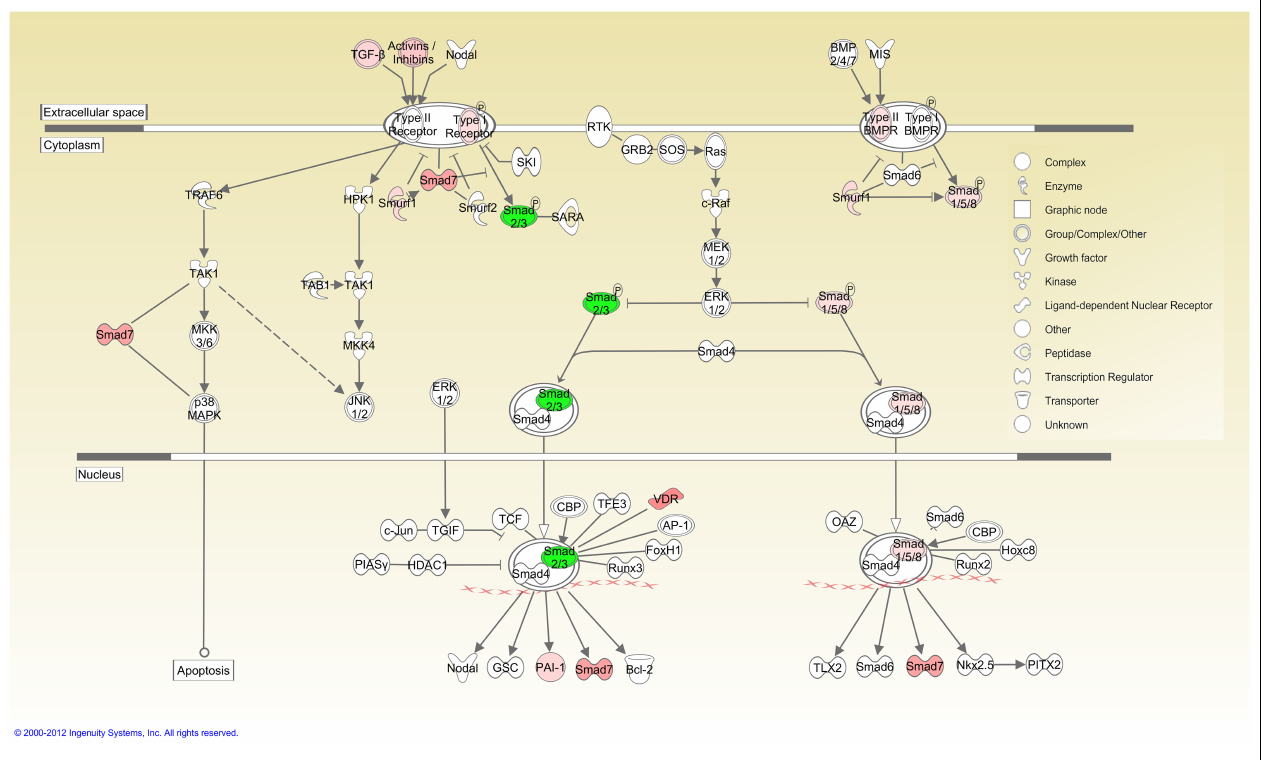
FIGURE 7 |TGF β signaling pathway overlaid with differentially expressed genes. Cellular localization of differentially expressed genes active in canonicalTGF β pathway was illustrated using the IPA Path Designer. Genes in Table 1 were uploaded to IPA as a dataset and analyzed using default settings. Acquired networks were overlaid withTGF β canonical pathway.The